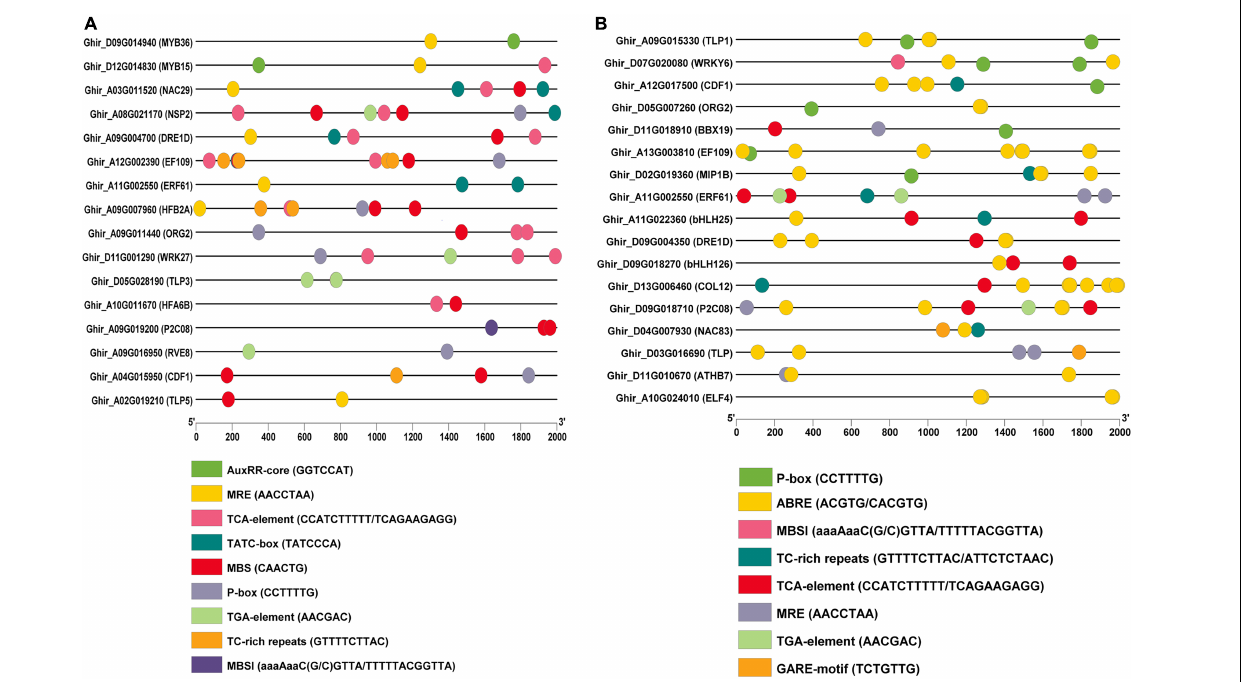
FIGURE 10 | Illustration of cis -regulatory elements of putative hub genes in (A) drought and (B) salt conditions. The micro-parts in diverse colors are the sequence of the putative elements.